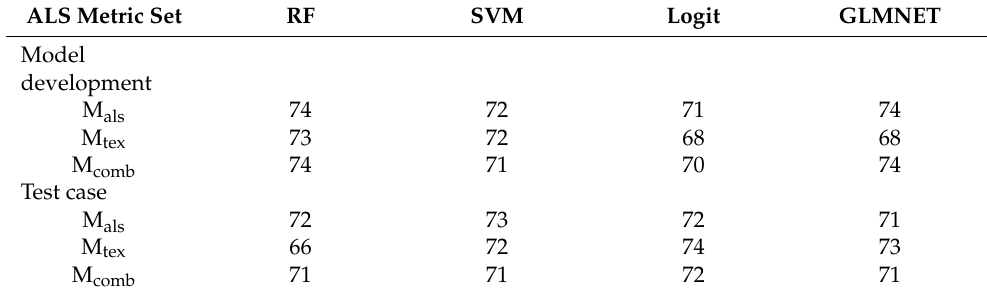
Table 2. Overall accuracies (%) of the SDD modality differentiation models using predictor vari- ables that were derived from the three ALS metrics sets (M als , M tex , and M comb ) for both model development and test case